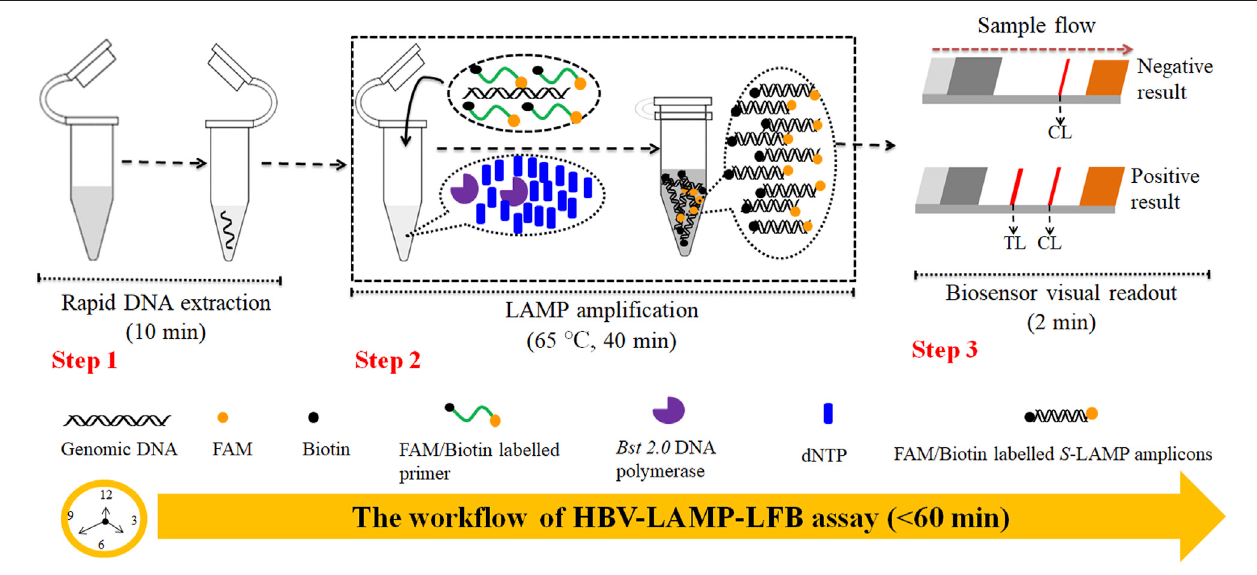
FIGURE 1 | Outline of the HVB-LAMP-LFB work fl ow. The HVB-LAMP-LFB assay systemcontains three closely linkedsteps: DNA extraction (step 1), LAMP (step 2), and gold nanoparticle-based LFB readout (step 4). The whole detection process can be completed within 60 min.